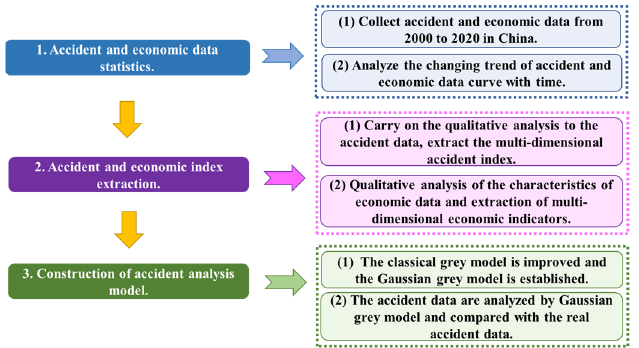
Figure 1. Flow chart of the research procedure.